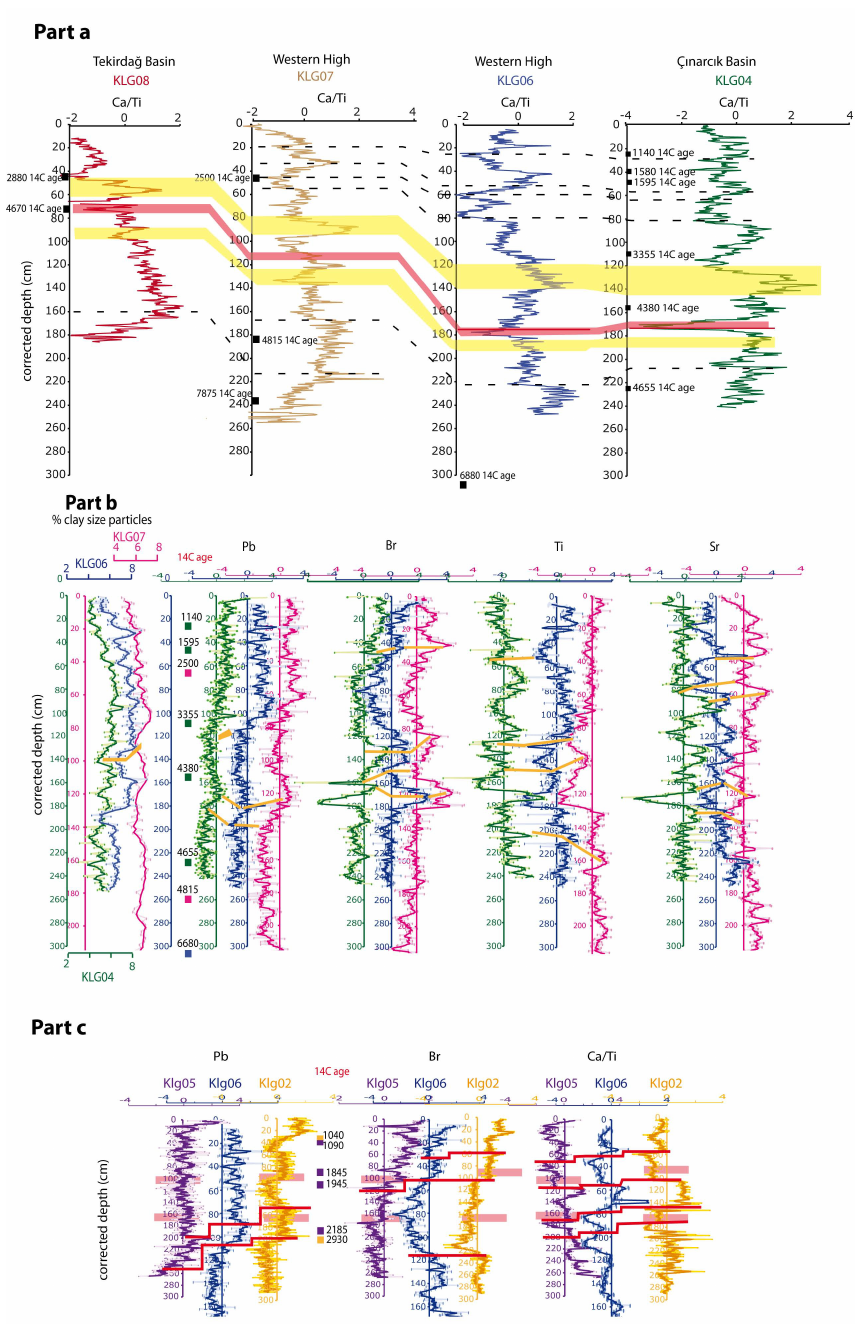
Fig. 8. Correlation of different cores based on XRF and granulometric data. All basal sandy layers have been removed. a : Ca/Ti ratio profiles for cores Klg08 (red curve), Klg07 (brown curve), Klg06 (blue curve) and Klg04 (green curve). Uncalibrated 14CyrBP are indicated on the left of the profiles (Table 2). Dashed black lines represent correlative highs or lows. b Profiles(from left to right) of clay-sized particles and of the standardized XRF data for Pb, Br, Ti and Sr for cores Klg04 (green curve), Klg06 (blue curve) and Klg07 (pink curve). Bold orange lines represent correlative highs or lows. c Profiles of the standardized XRF data with from the left to the right Pb, Br and Ca/Ti ratio for the cores Klg02 (yellow curves), Klg05 (purple curves) and Klg06 (blue curves). Bold red lines represent key points of correlation. Pink rectangles indicate the location of the top fine-grained of the largest turbidites in Klg05 and